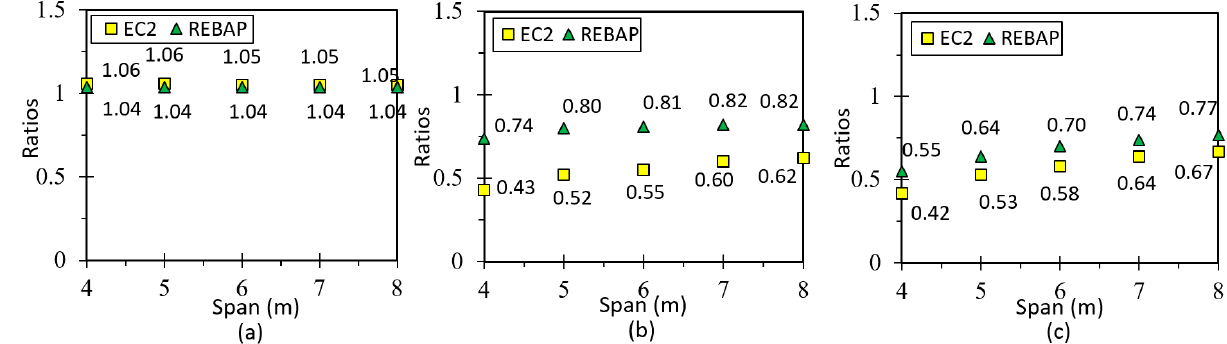
Figure 20. Ratios values for ( a ) LM, ( b ) 1NLM and ( c ) 2NLM, for fixed-ended supported slab.